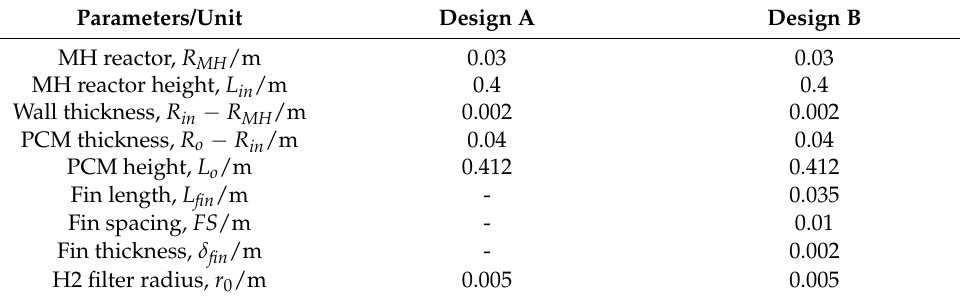
Table 3. Size parameters of the two MHR-PCM